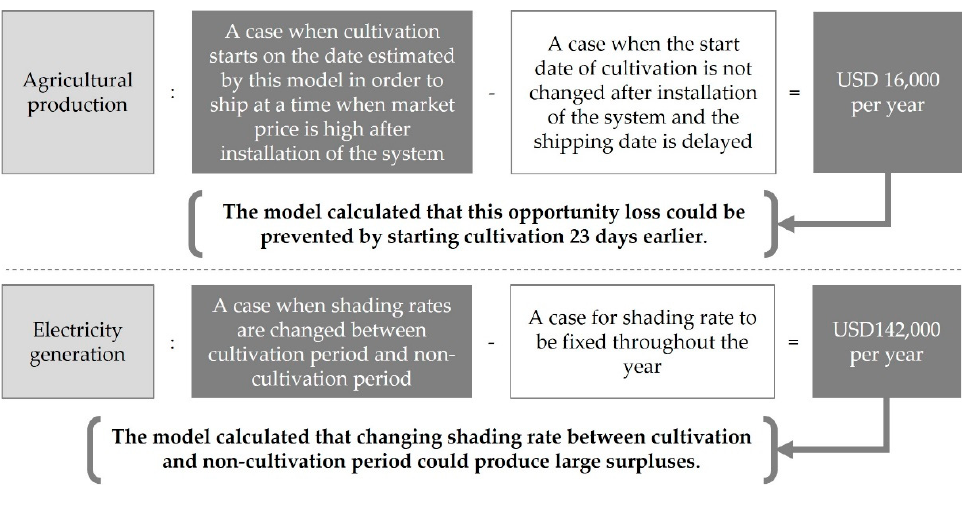
Figure 12. Summary of values estimated by the model.